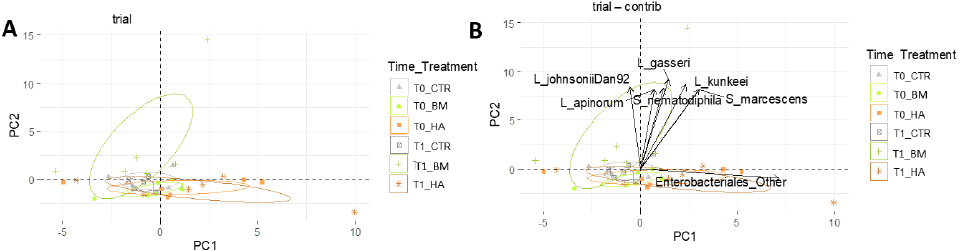
Figure 6. PCA analysis. ( A ) PCA without driver species relevance. ( B ) The graph (contrib) includes the variables with cos2 > 0.65 expressed in